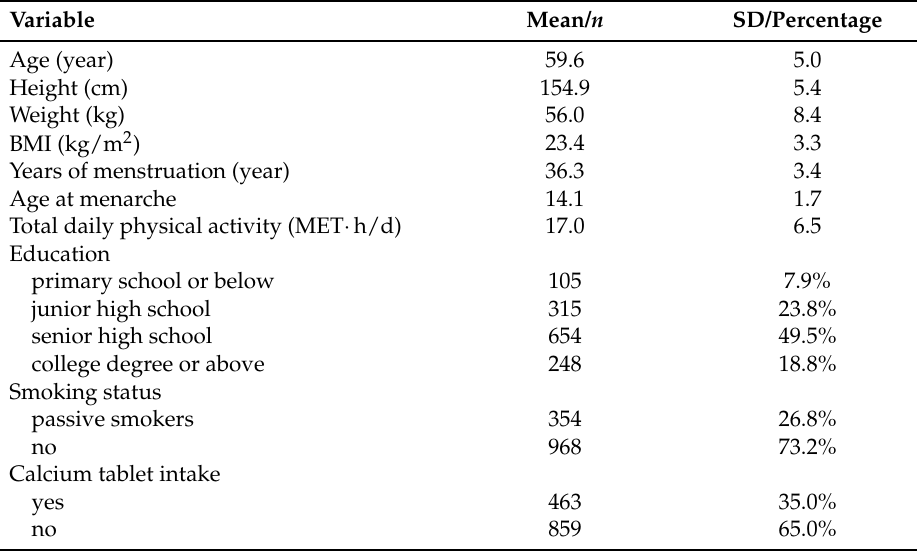
Table 1. Basic information of studied subjects ( n =